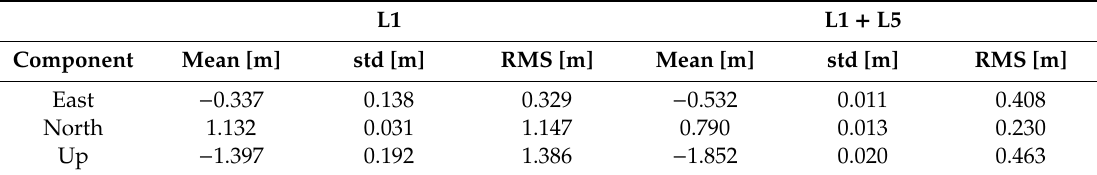
Table 7. Positioning results considering the GPS-only constellation. L1